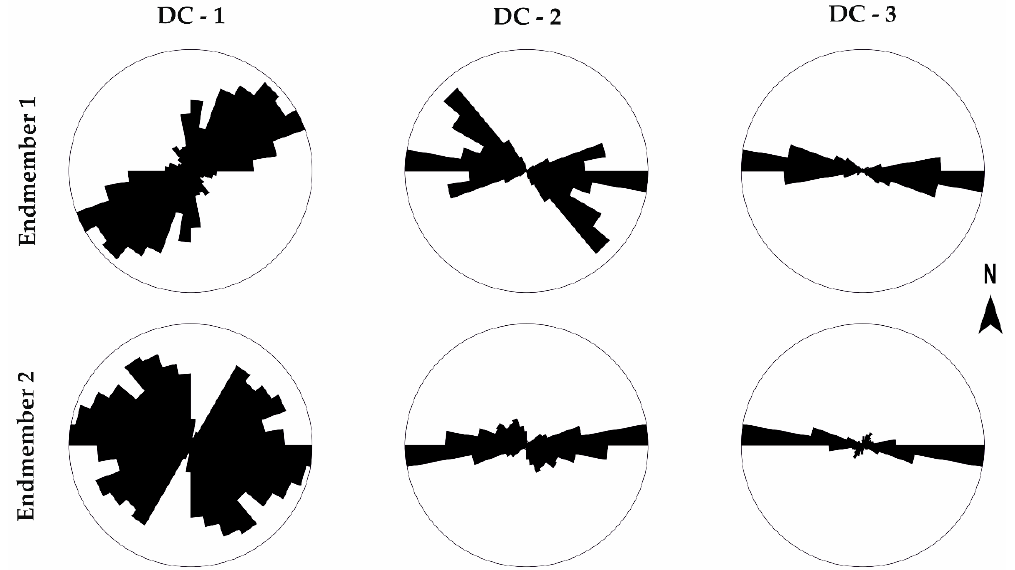
Figure 9. Rose diagrams illustrating the orientation of the veins in the first two endmembers of each sample. The azimuth is calculated here based on the horizontal (E–W) layout of the drill-cores as illustrated in Figure